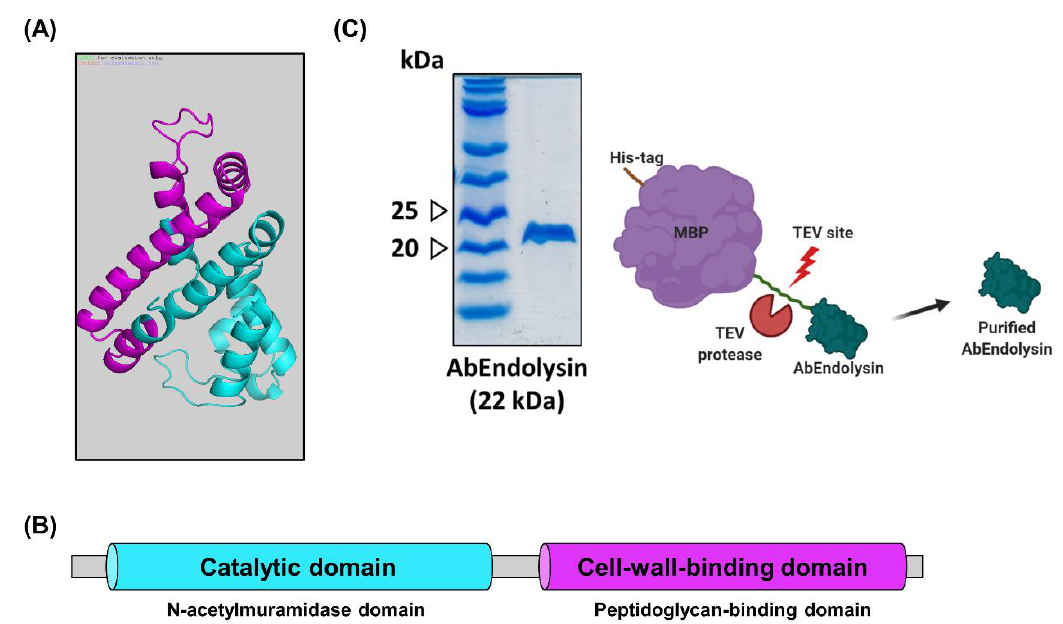
Figure 4. Purification of recombinant AbEndolysin. ( A ) The 3D structure of AbEndolysin was predicted using Phyre. It is composed of nine alpha helixes and three beta sheets. ( B ) AbEndolysin consists of two domains. The N-terminal is the N -acetylmuramidase domain (sky-blue), and the C-terminal is the peptidoglycan-binding domain (purple). ( C ) Schematic of AbEndolysin. Purified recombinant AbEndolysin was separated on a 10% Tricine SDS–PAGE gel.